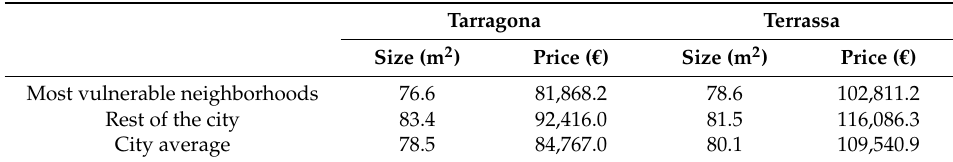
Table 7. Mean size and market price of HOBs in the most vulnerable neighborhoods and in the rest of the city.